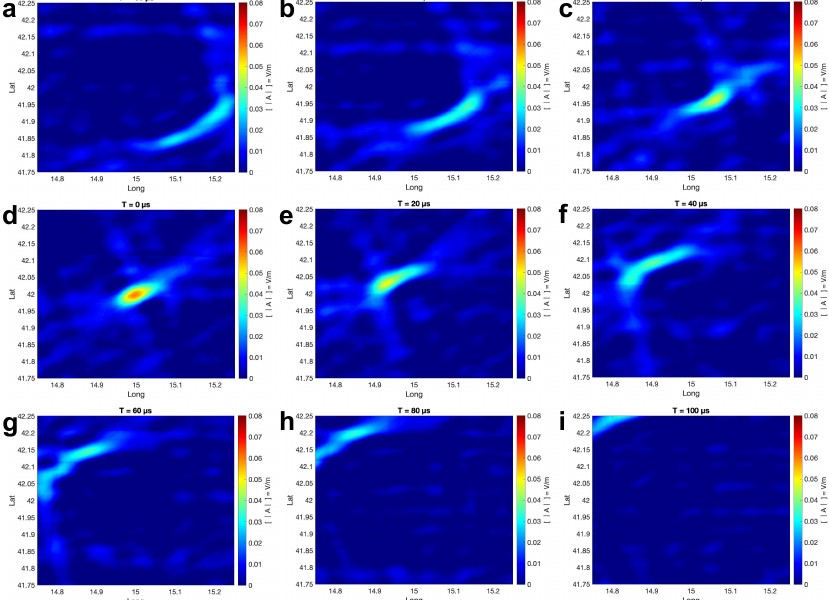
Figure 17. The amplitude maps using the impulse response function filtered waveforms with a simulated lightning location of 15°E and 42°S. Each sub-figure ( a – i ) is the amplitude map at a different